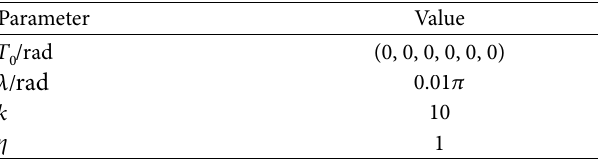
Table 3: Table of manipulator initialization